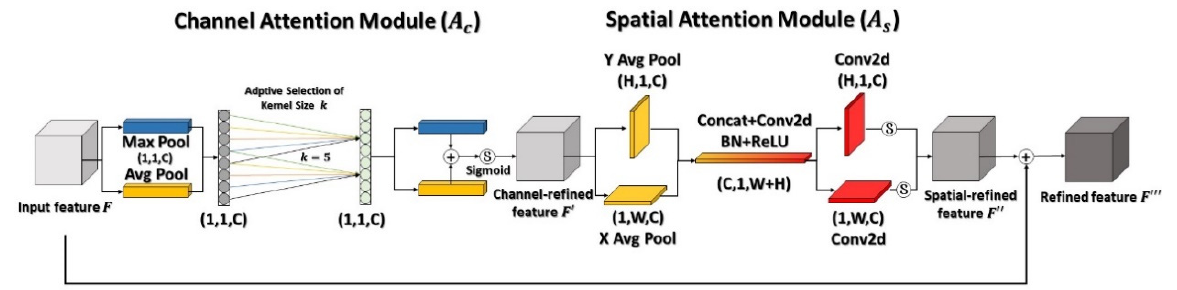
Figure 8. The overall structure of LRCA-Netv2 contains the original channel attention mechanism A c and the modified channel attention mechanism A s .